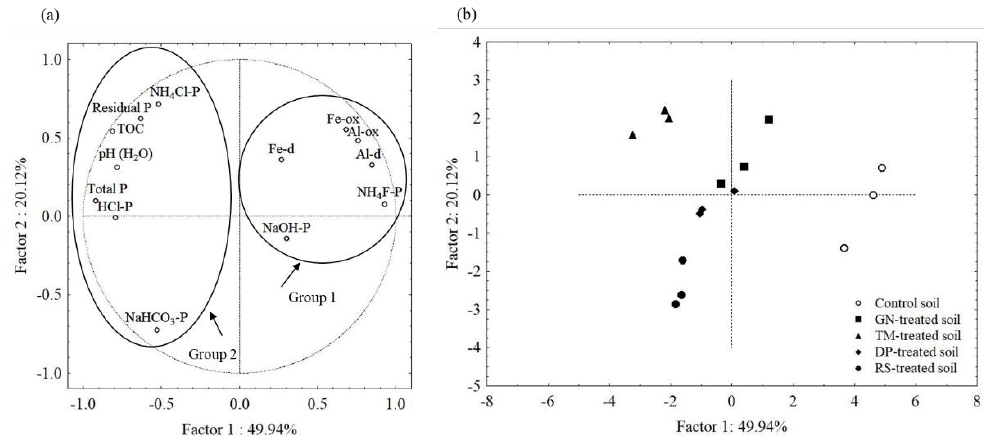
Figure 3. Principle component analysis based on phosphorus fractionation and soil properties of tropical sandy soils, ( a ) distribution of properties (variables) and ( b ) distribution of cases. NH 4 Cl-P = NH 4 Cl-extractable P; NH 4 F-P = NH 4 F-extractable P; NaHCO 3 -P = NaHCO 3 -extractable P; HCl-P = HCl-extractable P.